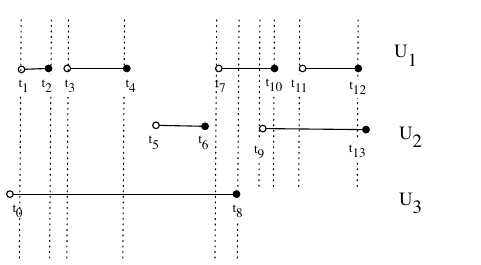
Figure 10. illustration of availability behavior of three users